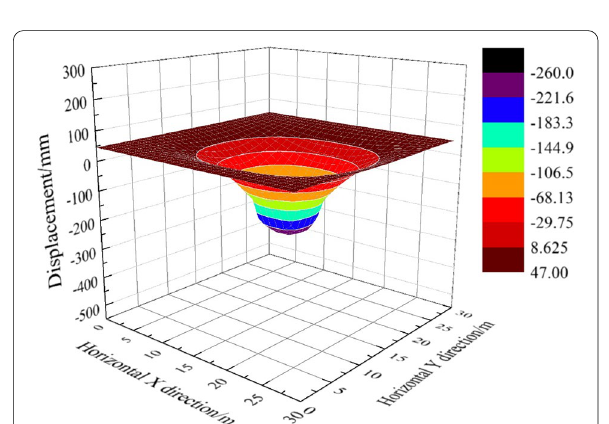
Fig. 11 Seismic subsidence of ground surface due to 0.40 g El Centro ground motion (cross-sectional view)